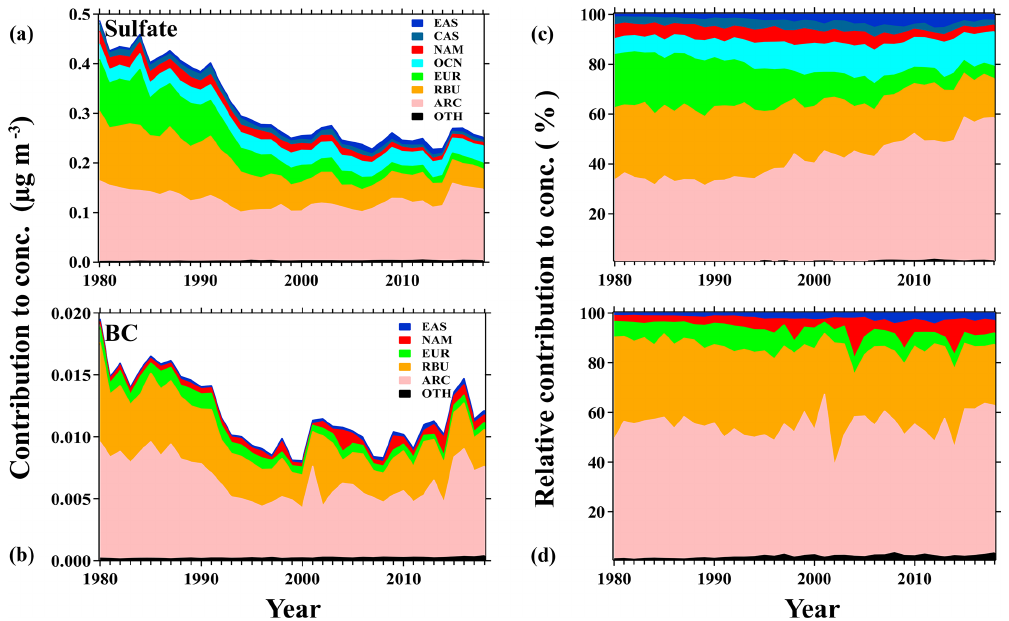
Figure 5. Time series (1980–2018) of absolute ( a , b ; µgm − 3 ) and relative ( c , d ; %) contributions of emissions from the major source regions to the simulated annual mean near-surface sulfate and BC concentrations averaged over the Arctic (66.5–90 ◦ N). The remaining source regions with annual contributions less than 3% are combined and shown as OTH (other regions in Fig. S2).